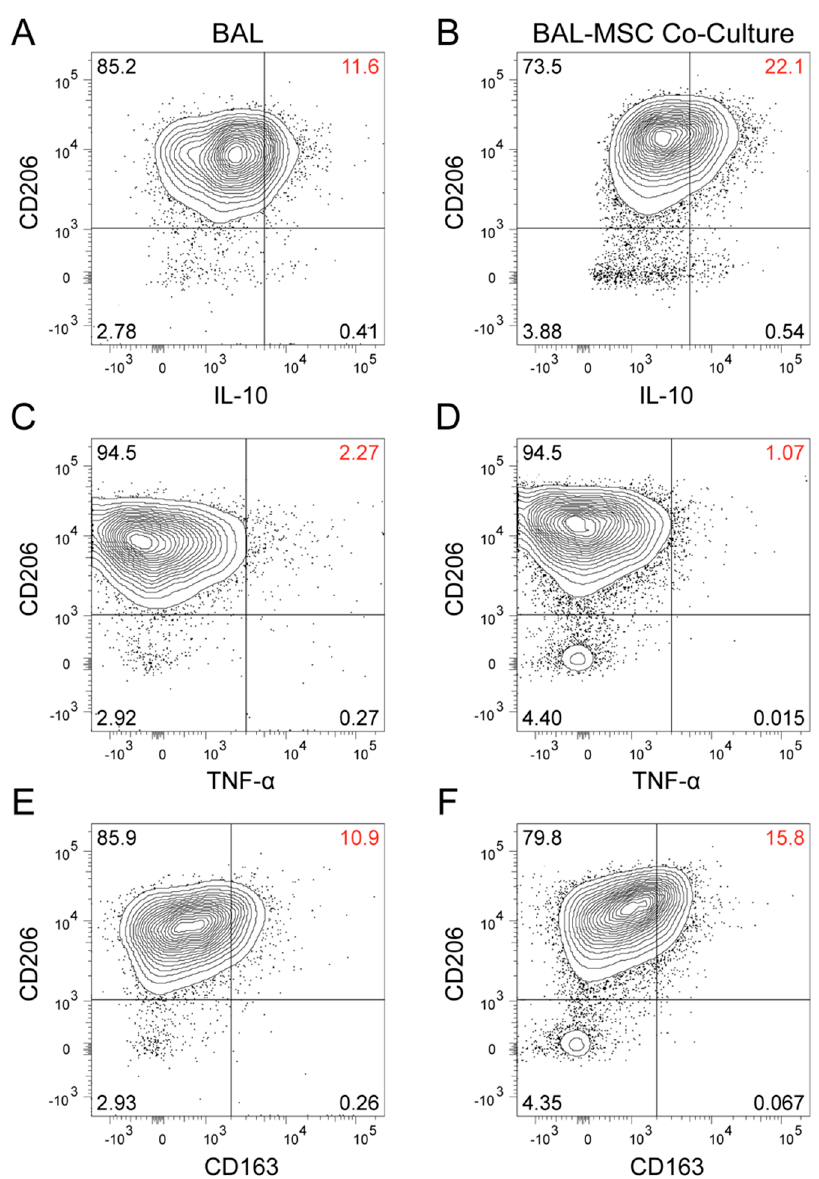
Figure 2. Flow cytometry analysis of mononuclear cells (90% of which were macrophages) freshly prepared from a sarcoidosis subject (sarcoidosis subject 16). Bronchoalveolar lavage (BAL) cells were plated and cultured for 16 h with ( B , D , F ) and without ( A , C , E ) the presence of bone marrow stromal cells (MSCs). Surface marker CD206 was used to identify alveolar macrophages (AMs), and intracellular flow cytometry was performed to determine changes in their cytokine production. Co-cultured BAL cells increased their IL-10 ( A , B ) and decreased their TNF- α ( C , D ) production. CD163 (a surface marker thought to indicate an anti-inflammatory state) also increased ( E , F ). These changes suggest a shift from a pro-inflammatory towards an anti-inflammatory state of AMs following contact with MSCs.